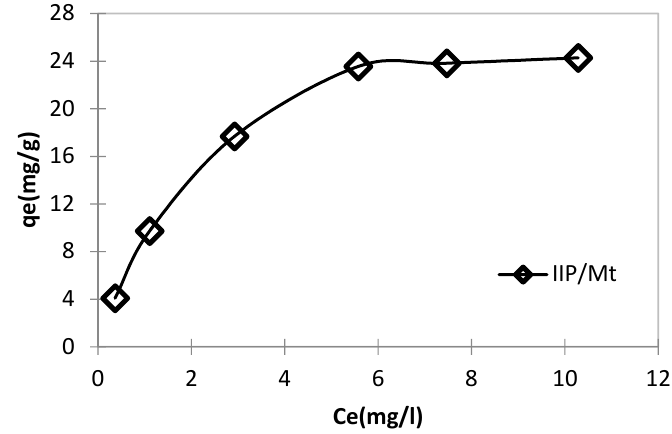
Figure 8. Adsorption isotherms of Cu 2+ on IIP/Mt nanocomposite at pH 5.